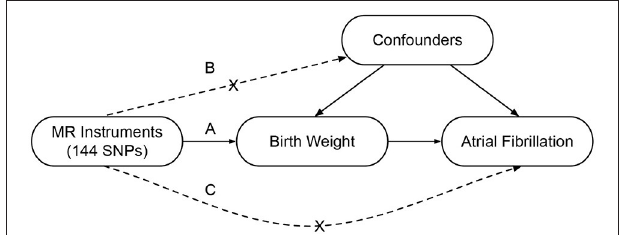
FIGURE 1 | Conceptual framework of the two-sample Mendelian randomization study design. This method is based on three key assumptions as follows: (A) The SNPs should be associated with the birth weight; (B) The SNPs should be independent of the confounders; (C) The SNPs should be associated with the atrial fibrillation only via the birth weight. MR, Mendelian randomization; SNP, single-nucleotide polymorphism.